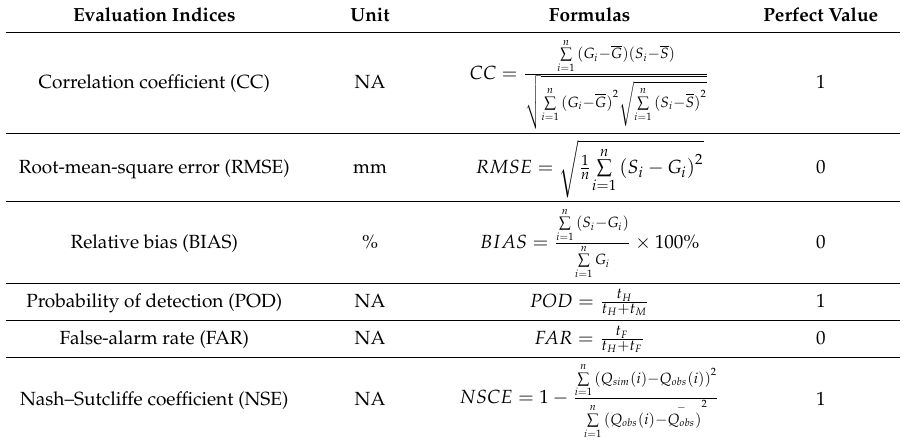
Table 1. Statistical evaluation indices for evaluating the SPPs and their hydrological utility.